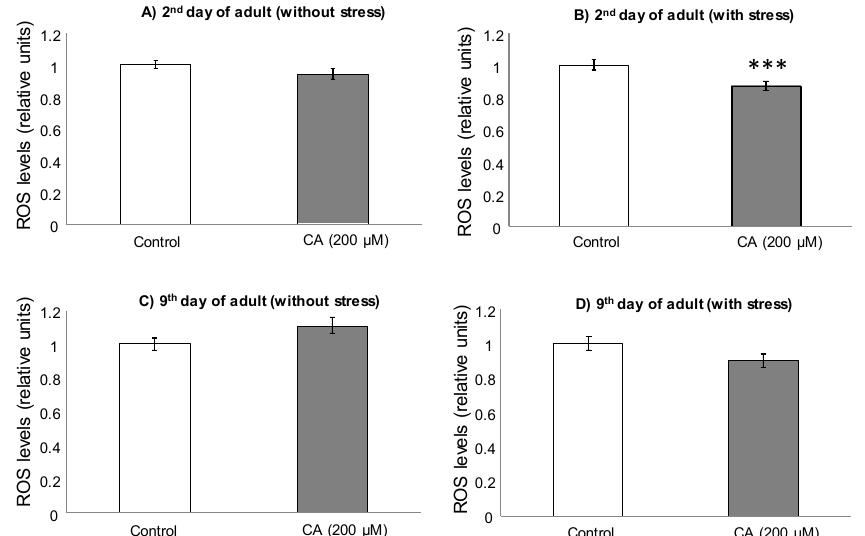
Figure 4. Relative intracellular levels of ROS, determined with DCFH-DA, in C. elegans on the second and ninth day of adulthood, cultivated in the presence or absence of CA (200 µ M), not submitted ( A , C ) and submitted to thermal stress ( B , D ). The results are standardized with respect to control and represent the mean ± SEM. The statistical significance was calculated using ANOVA (*** p < 0.001).